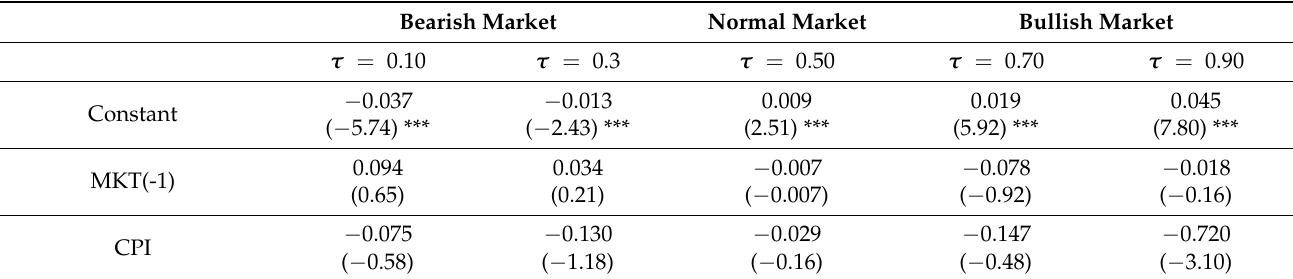
Table 6. Results of Quantile Regression for Islamic Stock